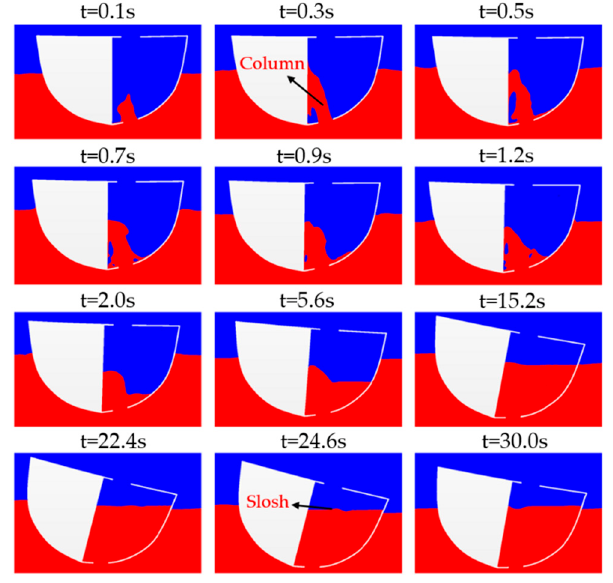
Figure 13. Visualization of the bottom flooding process.